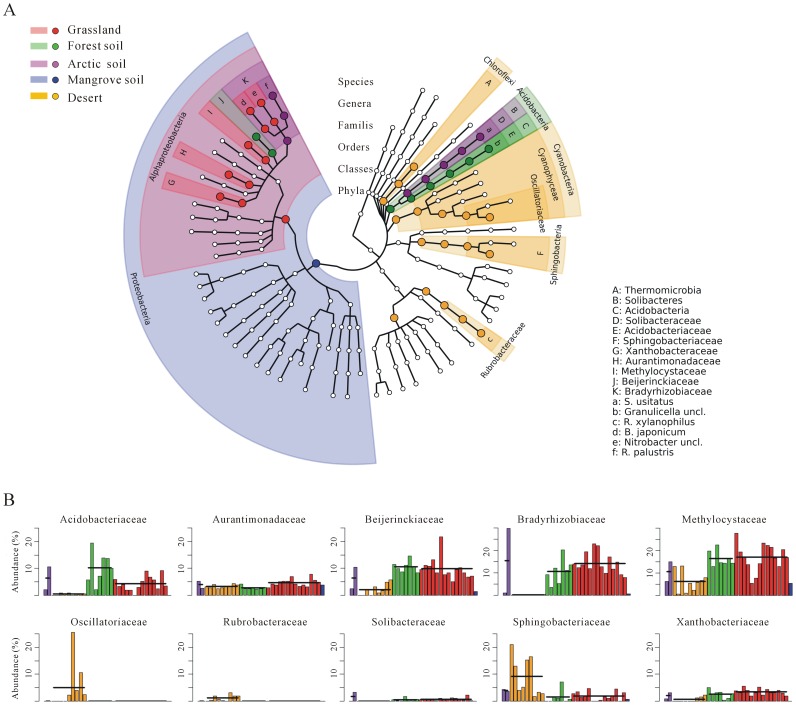
Taxonomic composition of soil microbial community based on the metagenomes from five soil habitats.A) Taxonomic cladogram showing all detected taxa (relative abundance ≥0.5%) in at least one sample. Taxonomic clades with more than five samples ≥0.5% abundance were used as inputs for LEfSe. Seven rings of the cladogram stand for domain (innermost), phylum, class, order, family, genus, and species (outermost), respectively. Enlarged circles in color are the differentially abundant taxa identified to be metagenomic biomarkers and the circle color is corresponding to the individual soil habitat in which the taxon is the most abundant among 5 soil ecosystems (Green for forest soil, red for grassland, purple for Arctic soil, blue for mangrove sediment, and orange for desert). B) The histograms of relative abundances of family-level biomarkers in each sample. Bacterial families significantly differential among all pairwise comparisons were illustrated. The average abundance of each family in the individual soil habitat was denoted by the horizontal line.